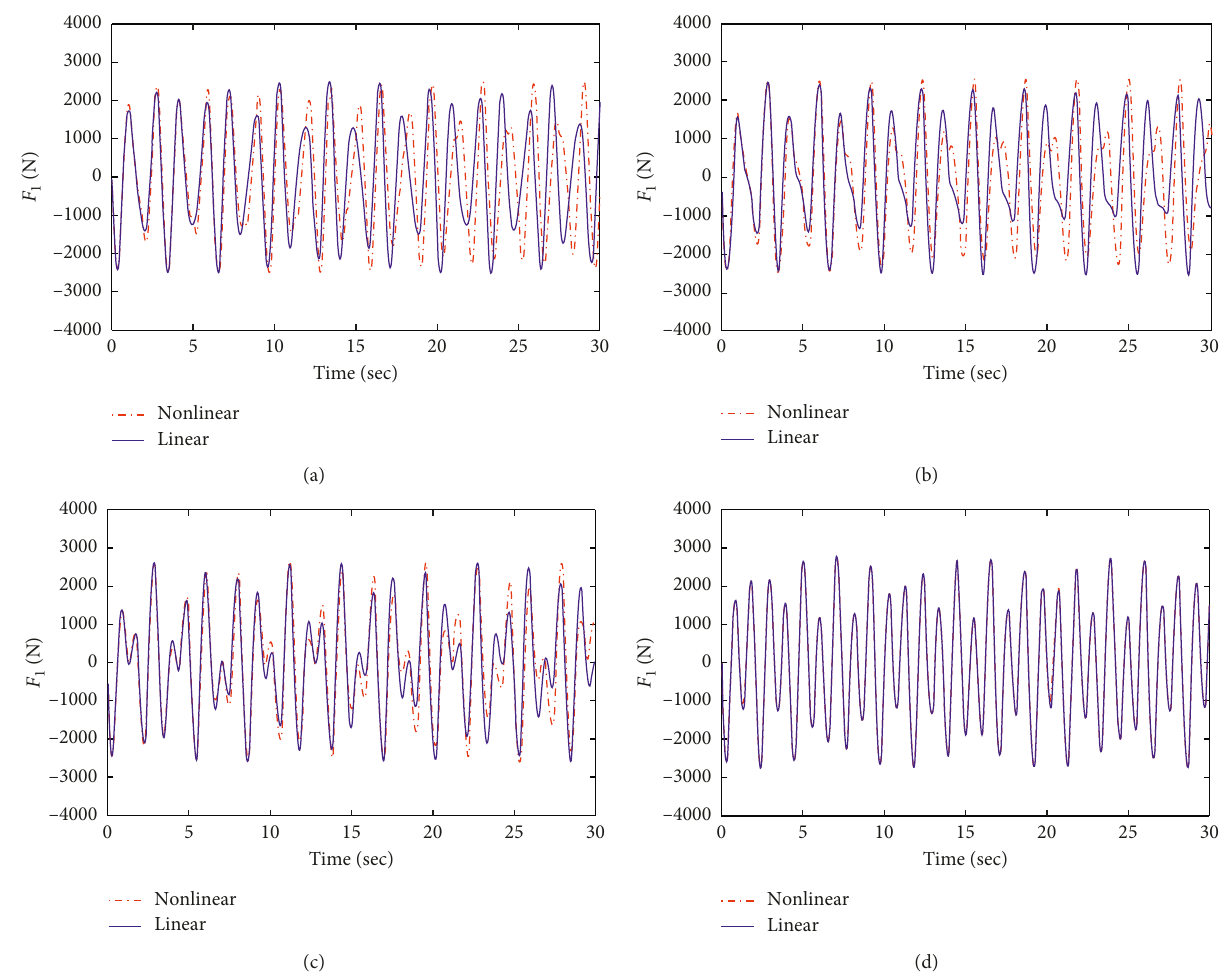
Figure 13: Time history of the resultant hydrodynamic force in the θ � 0 direction under the lateral harmonic excitation for r